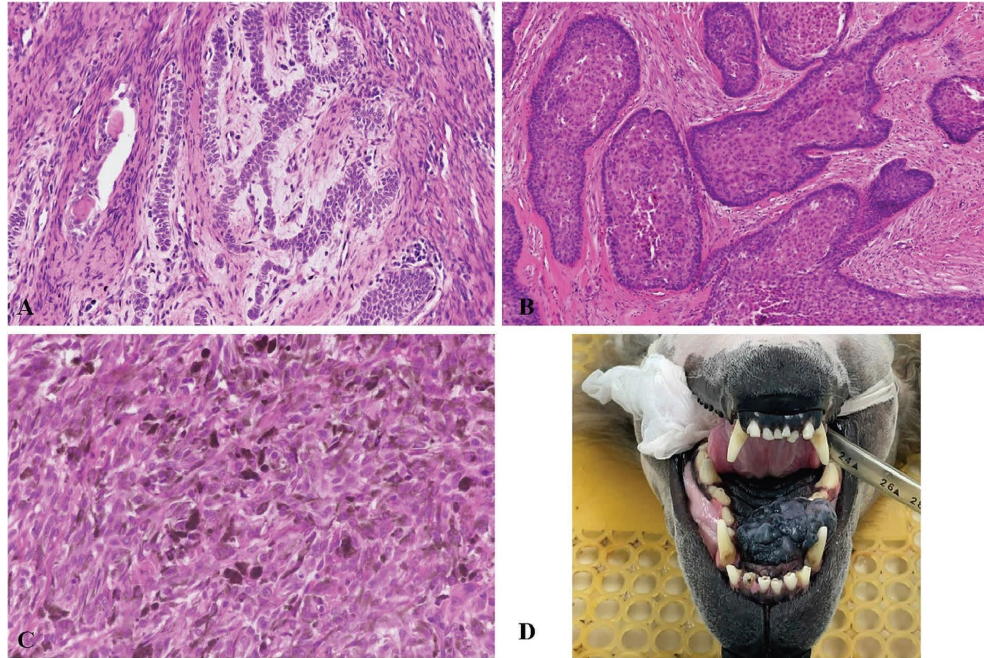
Figure 2: Histopathology of oral tumor mass stained with hematoxylin and eosin (H&E) stain and gross lesion of canine oral mass in this study. Tis fgure presents the histopathology of acanthomatous ameloblastoma (20x,(a)), squamous cell carcinoma (SCC, 20x,(b)), malignant melanoma cells metastasis to the regional lymph node (40x,(c)), and the gross lesion of oral mass at the maxilla area